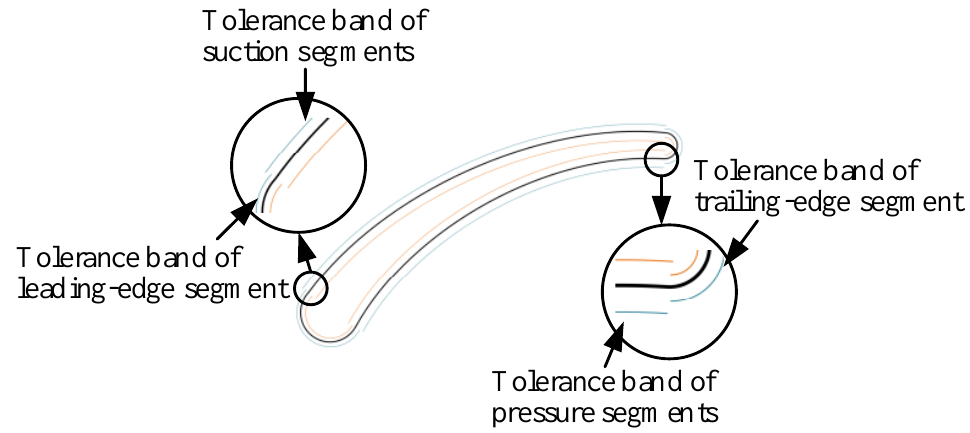
Figure 4. A profile curve of the blade and a non-uniform tolerance zone.